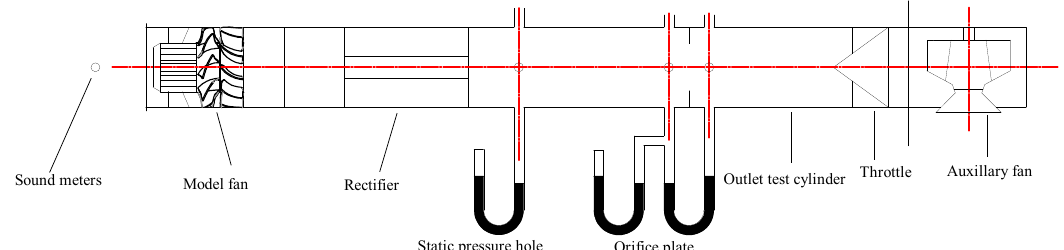
Figure 4. Experiment system for the axial-flow fan.